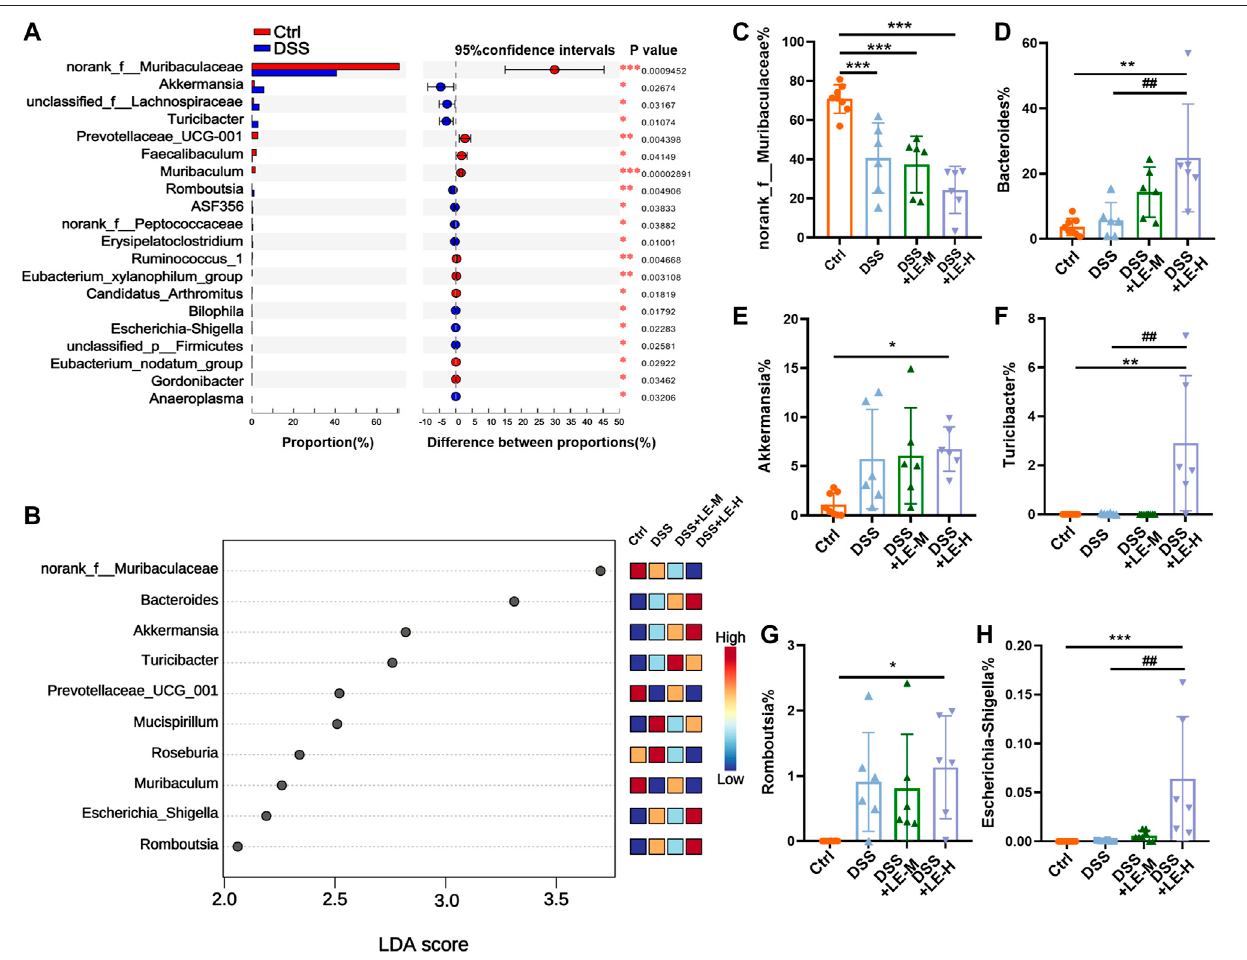
FIGURE7 | Generic differenceamong groups after excessive longan treatment in colitic mice. (A) Genericdifference betweenCtrl and DSS group mice. (B) Linear discriminantanalysis(LDA)scoreandLDAeffectsize(LEfSe)analysis(LDAscore > 2).Genericdifferenceamonggroups: (C) norank_f__Muribaculaceae (D) Bacteroides ; (E) Akkermansia ; (F) Turicibacter ; (G) Romboutsia ; (H) Escherichia-Shigella . Data are presented as mean ± SD ( n (cid:1) 8 for Ctrl group; n (cid:1) 6 for other groups). * p < 0.05, ** p < 0.01, *** p < 0.001, compared to Ctrl; # p < 0.05, ## p < 0.01, compared to DSS